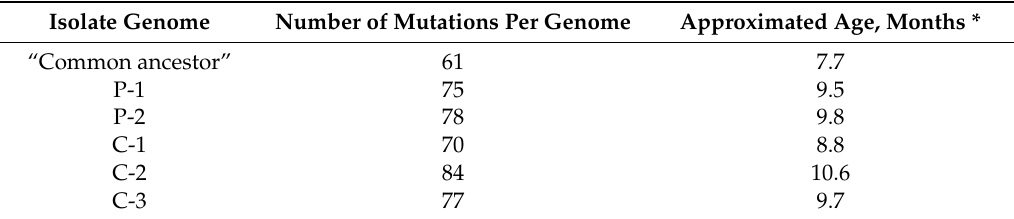
Table 2. Ages of Syzran isolates and their hypothetical common